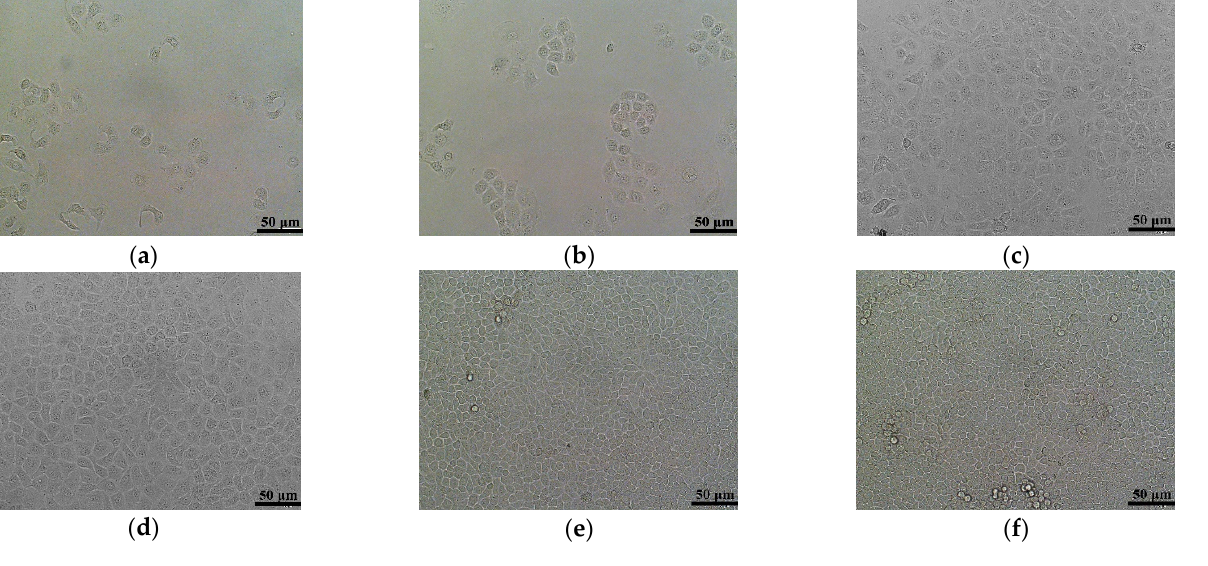
Figure 7. ( a ) A two-dimensional (2D) cell culture image on day 1. ( b ) A 2D cell culture image on day 3. ( c ) A 2D cell culture image on day 5. ( d ) A 2D cell culture image on day 7. ( e ) A 2D cell culture image on day 10. ( f ) A 2D cell culture image on day 13.